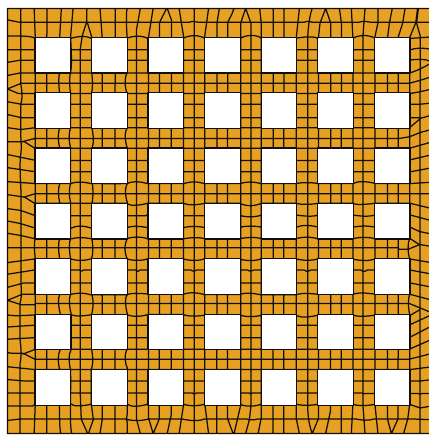
Figure 7: Square hole grids.